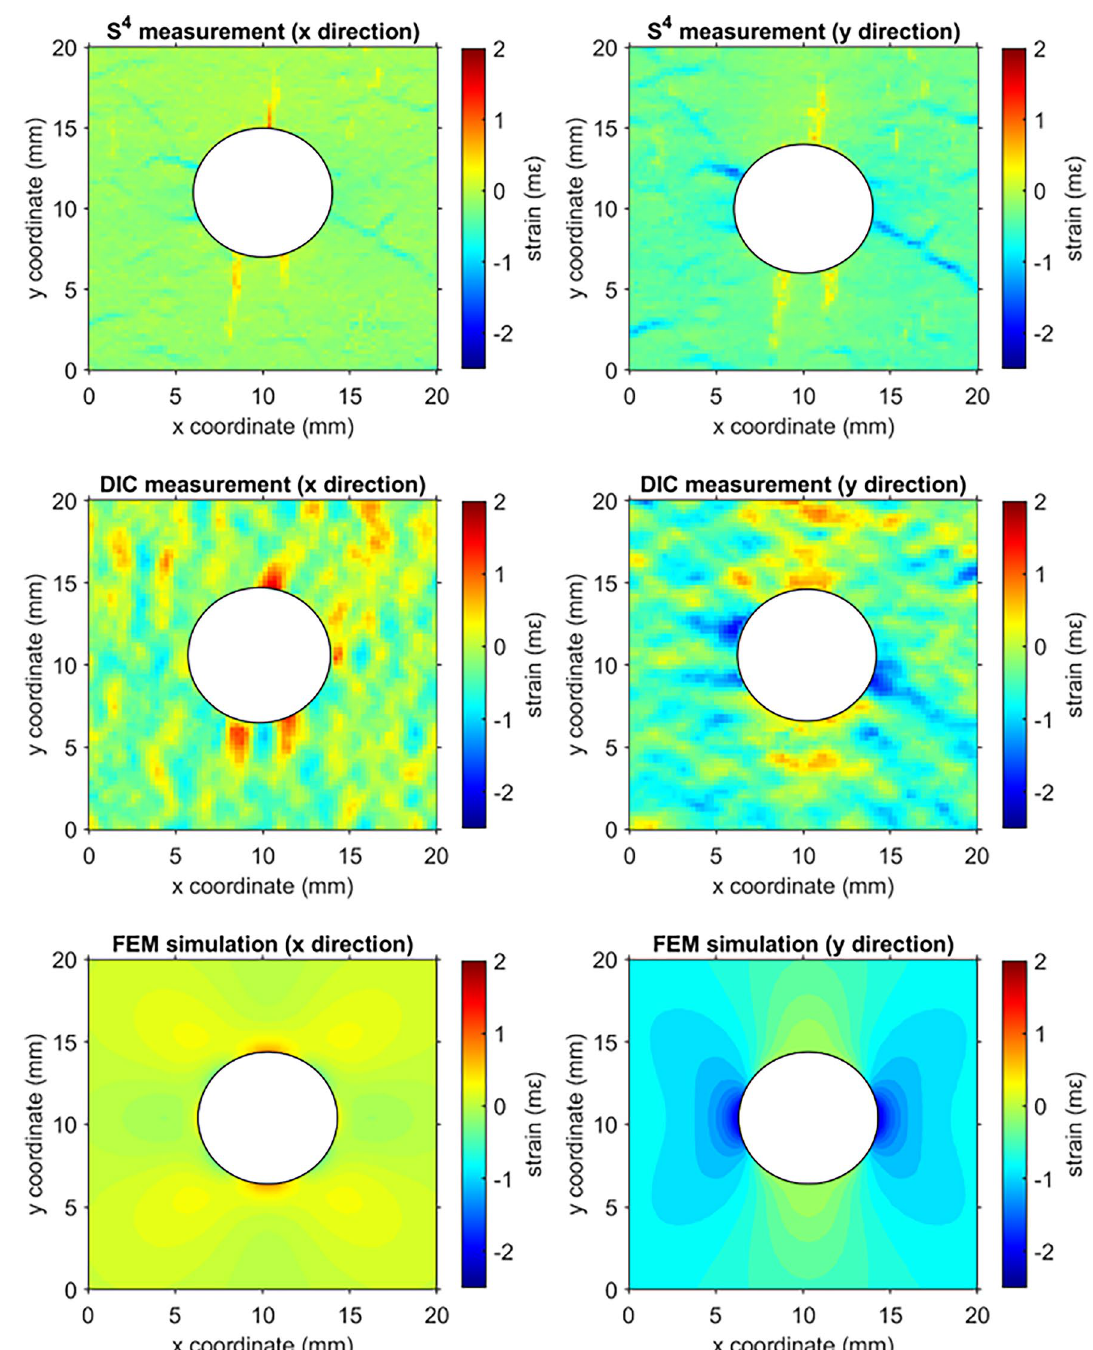
Figure 6. Strain maps of a concrete specimen with a central hole that was compressed along the y-axis. Rows from top to bottom show strain measured with S 4 , DIC, and simulated by FEM computations. The left panels show strain components perpendicular to the stress axis and right panels show components parallel to the stress